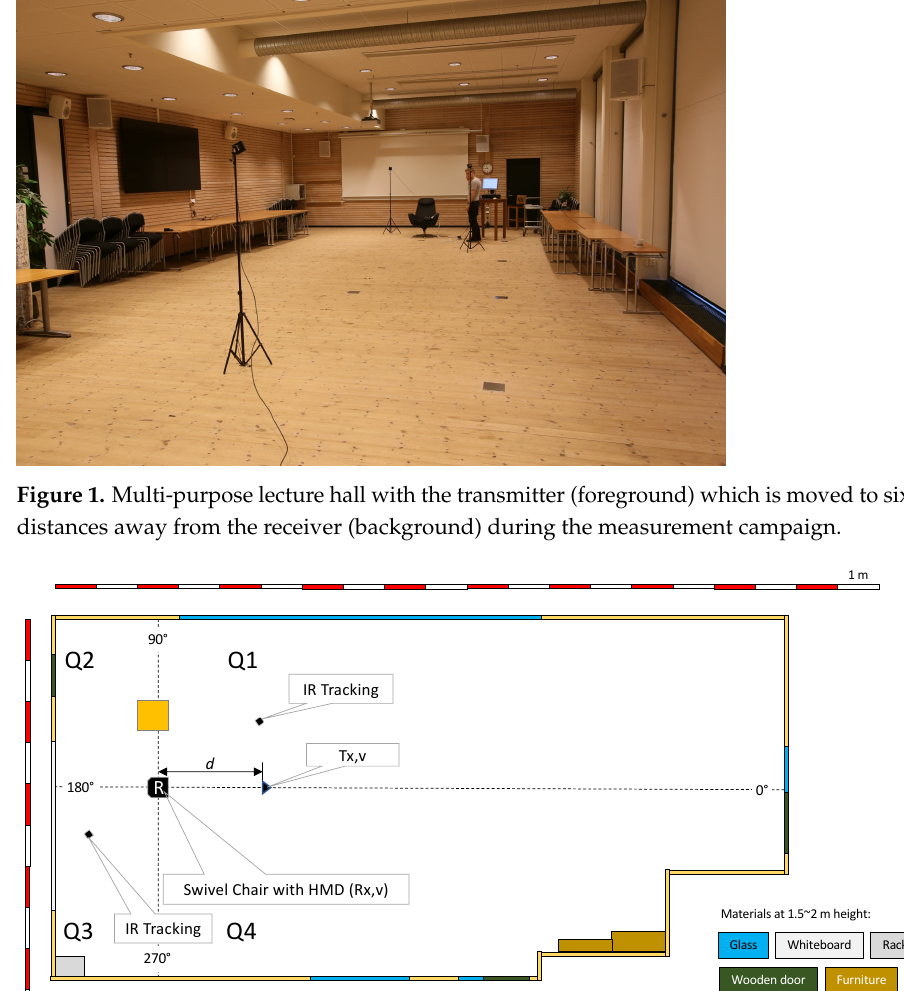
Figure 2. Floor plan of the multi-purpose lecture hall including placement of the measurement equipment and introducing a room partitioning into quadrants around the receiver (Tx,v: Transmitter of the 60GHz video link; Rx,v: Receiver of the 60GHz video link; Q1-4: Quadrants; IR: Infrared; HMD: Head-mounted